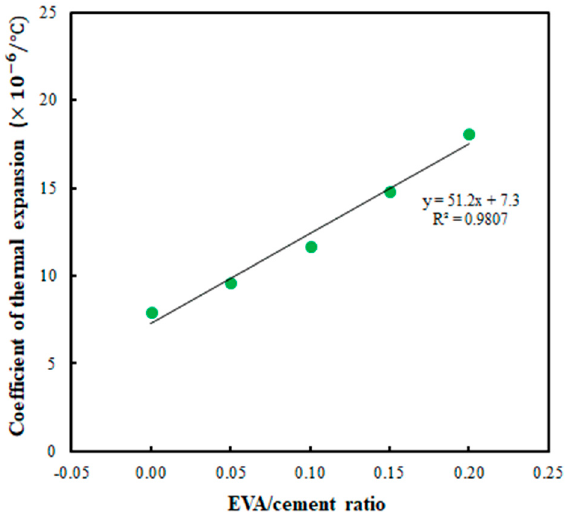
Figure 14. Relationship between the EVA/cement ratio and coefficient of thermal expansion.